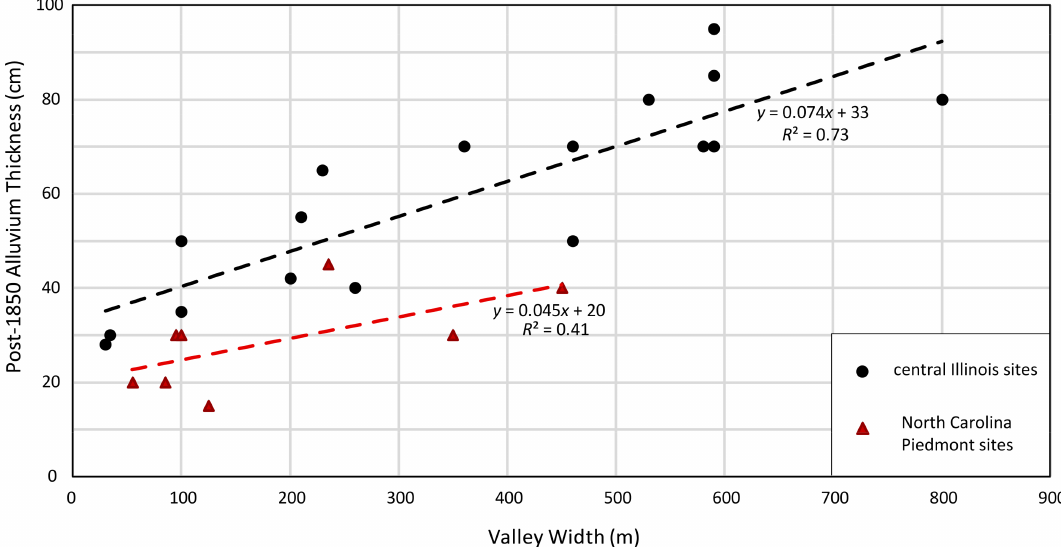
Figure 6. Thickness of post-1850 alluvium versus valley width from 8 sites in the North Carolina Piedmont (this study) and 17 sites in the Upper Sangamon River Basin of central Illinois (data from [6]). Data from Betty’s Milldam and Lake Decatur sites are not